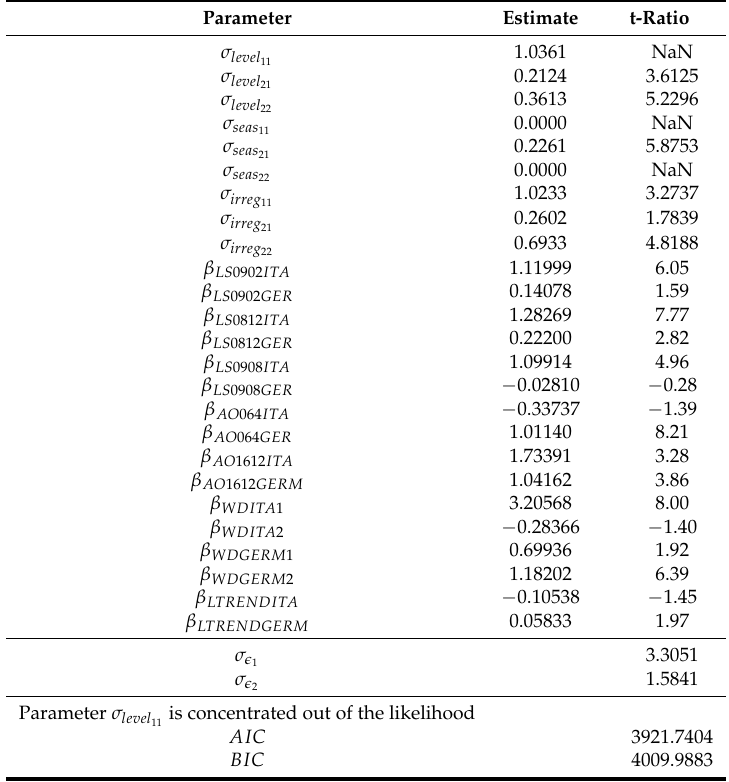
Table A5. Barebone model variables: IPI t intermediate goods LCVDE t in